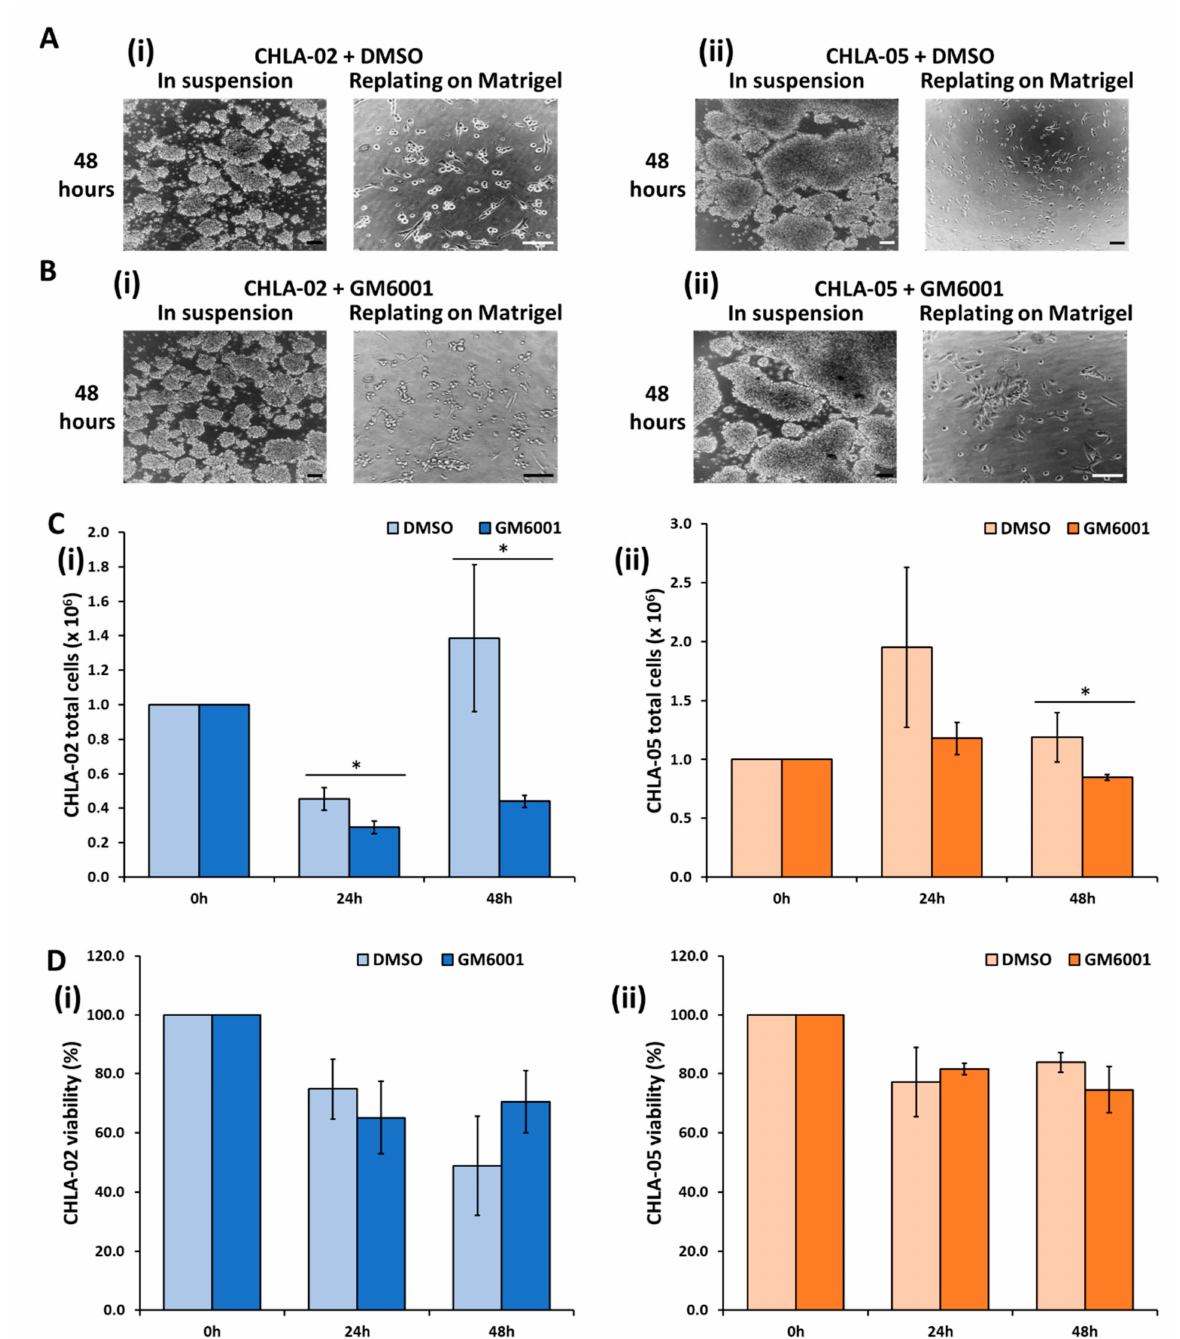
Figure 5. The effect of GM6001 on the morphology, proliferation, and viability of the CHLA-02 and CHLA-05 cell lines. The effect of ( A ) DMSO and ( B ) GM6001 treatment on ( i ) CHLA-02 and ( ii ) CHLA-05 morphology. Scale bar: 200 µ m. ( C ) The cell proliferation and ( D ) viability of ( i ) CHLA-02 and ( ii ) CHLA-05 under the treatment of either DMSO or 10 µ M of GM6001. *: p -value < 0.05, based on the Student’s t